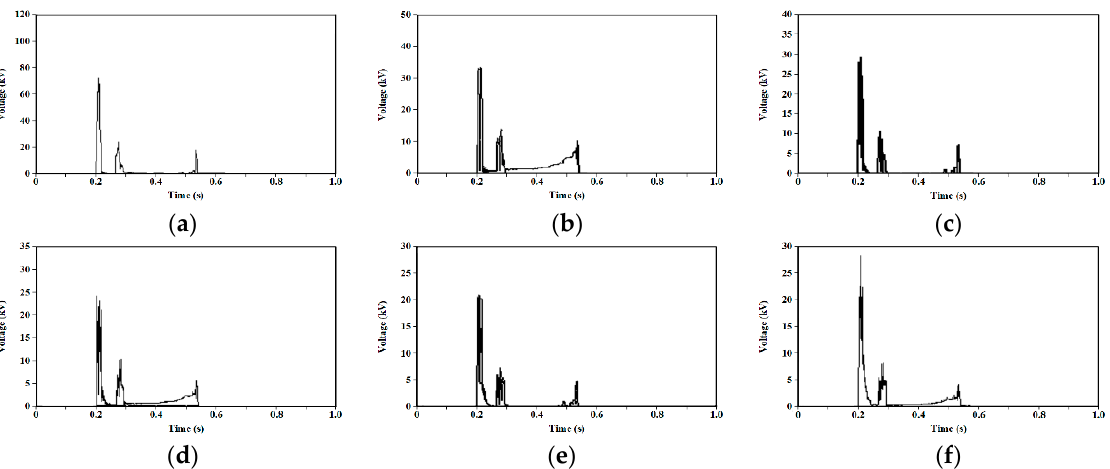
Figure 6. Harmonics calculation results for the waveform in Figure 4a: ( a ) 2nd harmonic; ( b ) 3rd harmonic; ( c ) 4th harmonic; ( d ) 5th harmonic; ( e ) 6th harmonic; ( f ) 7th harmonic.